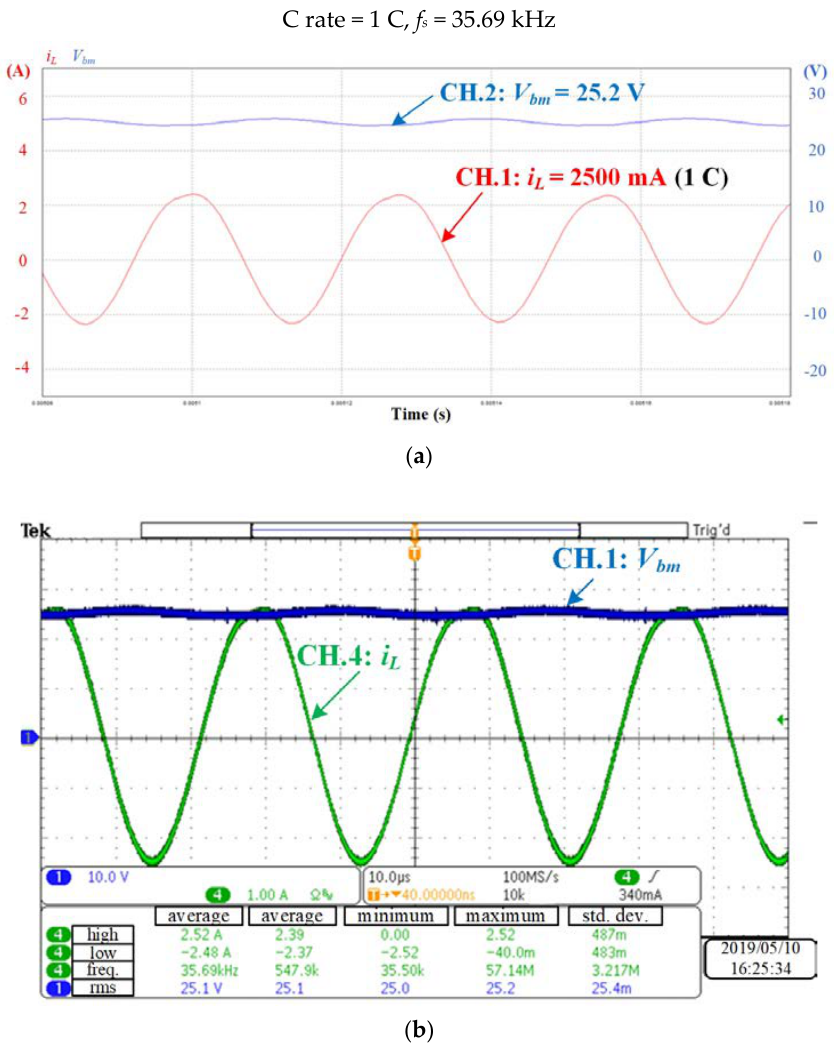
Figure 12. Measured and simulated waveforms of the proposed sinusoidal load under C rate = 1 C: ( a ) simulated waveforms; ( b ) measured waveforms.